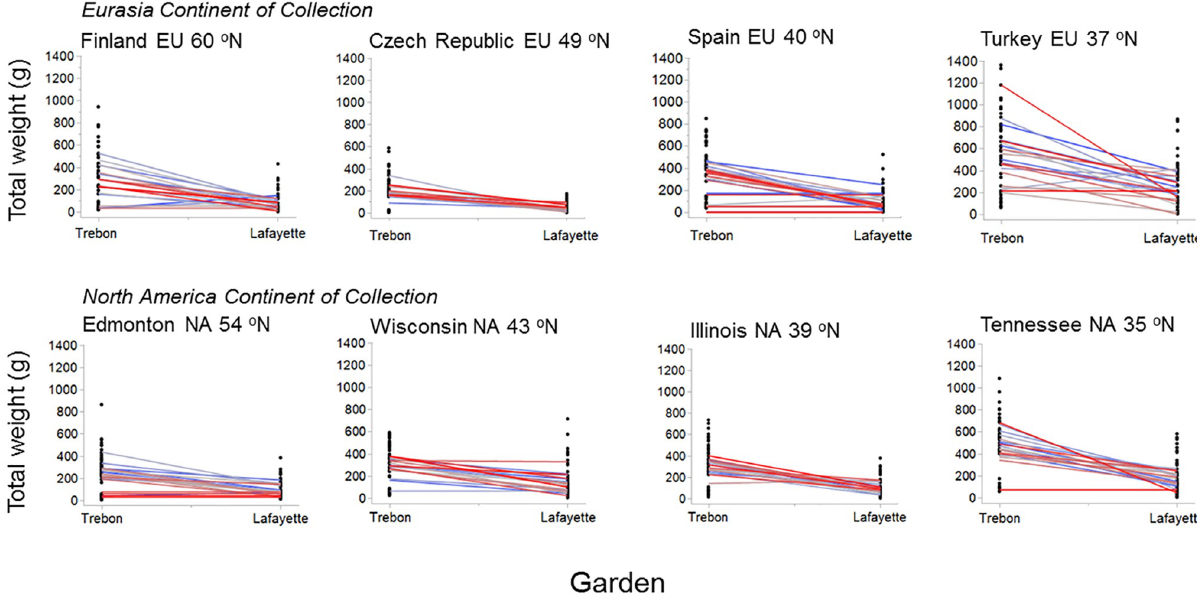
Fig 2. Reaction norms for total biomass (g) constructed from plants grown from the seeds of the same maternal plant grown in the gardens in T ř ebo ň ,Czech Republic and Lafayette, Louisiana (cold/dry vs. hot/humid garden). Individual maternal plants are depicted by a gradient of blue to red